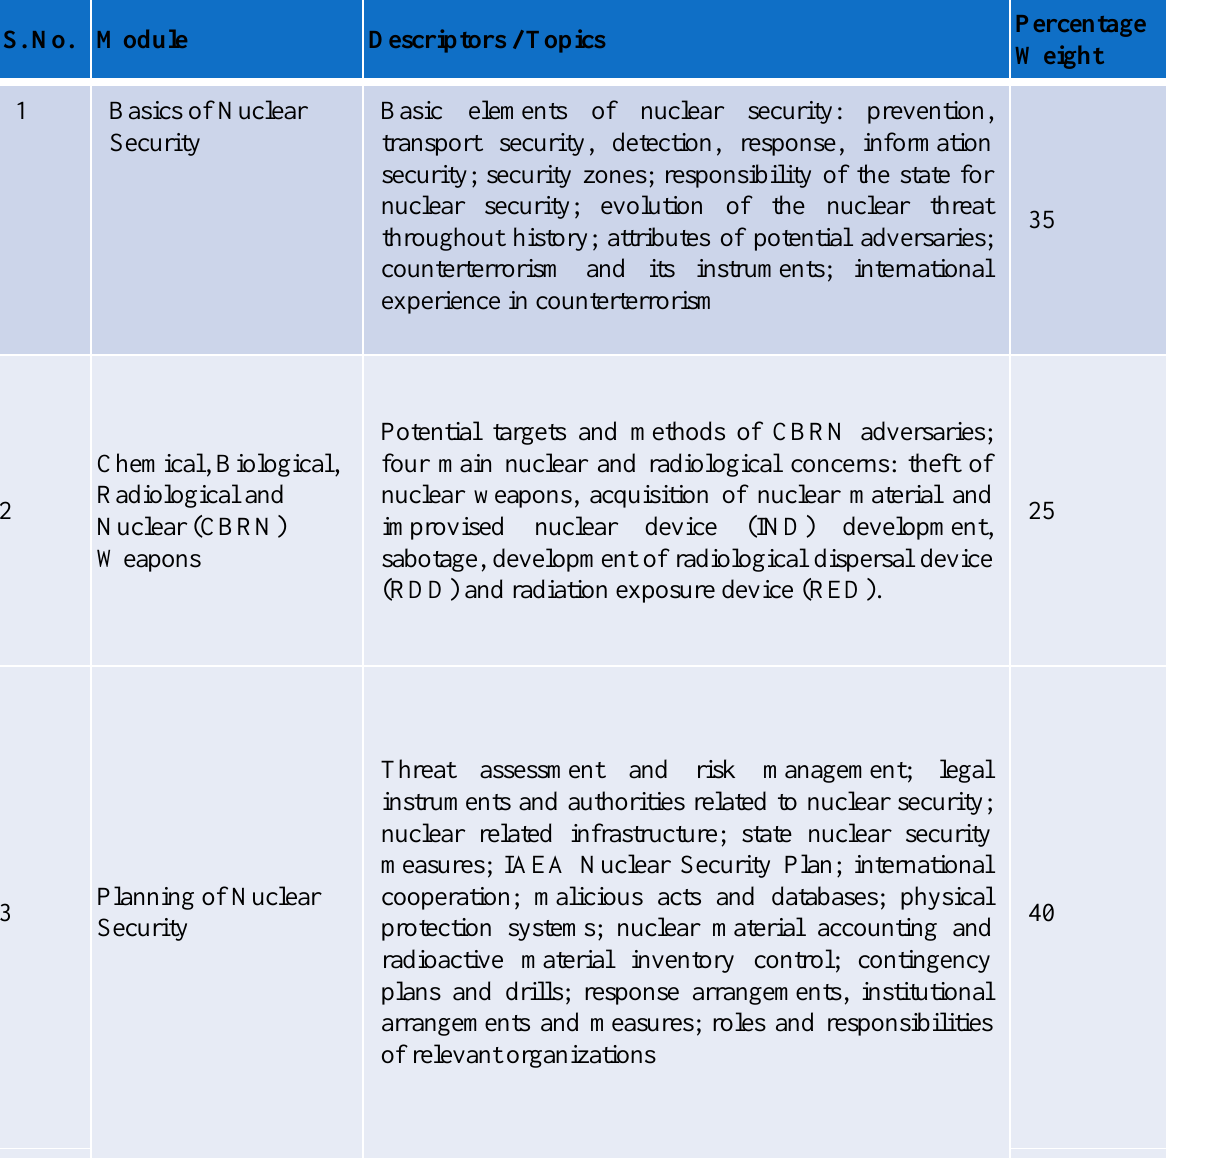
Table 1: Outline of the Undergraduate Course, “Introduction to Nuclear Security” S. No.